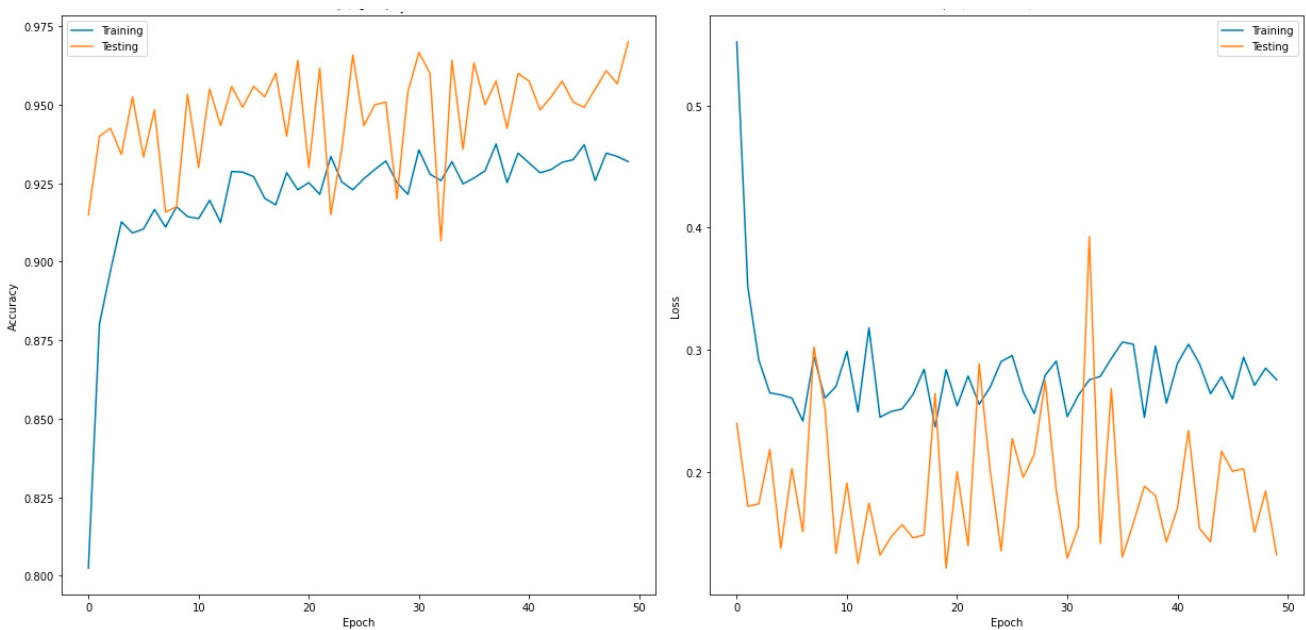
Figure 5. Accuracy ( left ) and loss curves ( right ) of VGG19 for four-class classifier.